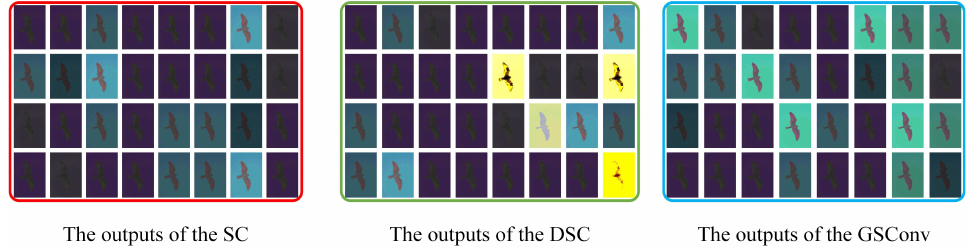
Figure 5. Comparison of SC, DSC, and GSConv output results.